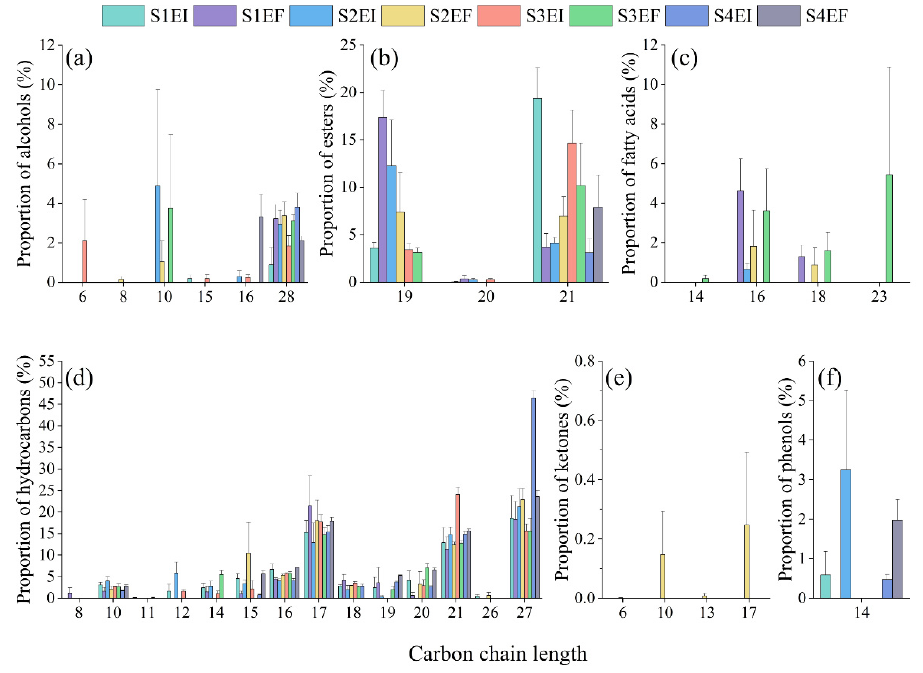
Figure 3. The carbon chain length distribution detected in the cuticular wax of Achnatherum inebrians according to the status of Epichloë gansuensis endophytes and in different growing periods: alcohols ( a ), esters ( b ), fatty acids ( c ), hydrocarbons ( d ), ketones ( e ), phenols ( f ). Values are mean, with standard error bars ( n = 3, S1: 1 month after sowing, S2: 2 months after sowing, S3: 3 months after sowing, S4: 4 months after sowing, EI: endophyte-infected and EF: endophyte-free).